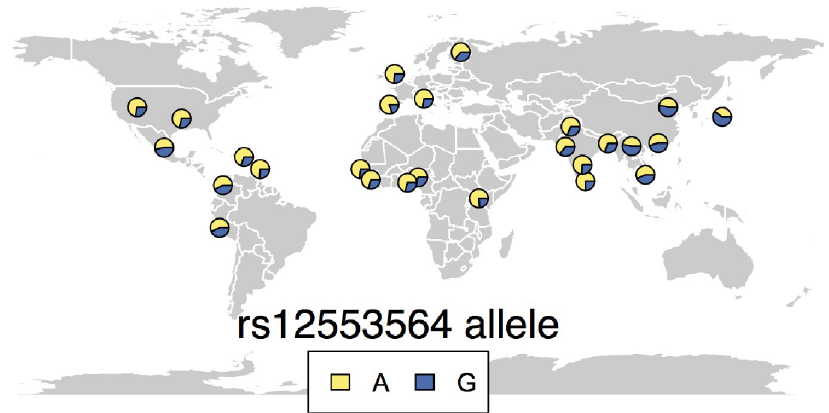
Fig 4. Worldwide allelic frequency at the rs12553564 locus. Geographic repartition of the rs12553564-G allele frequency across populations from 1000 genomes phase 3. The frequency of the G allele (blue) is presented in the different populations as the proportion out of 1 of the depicted